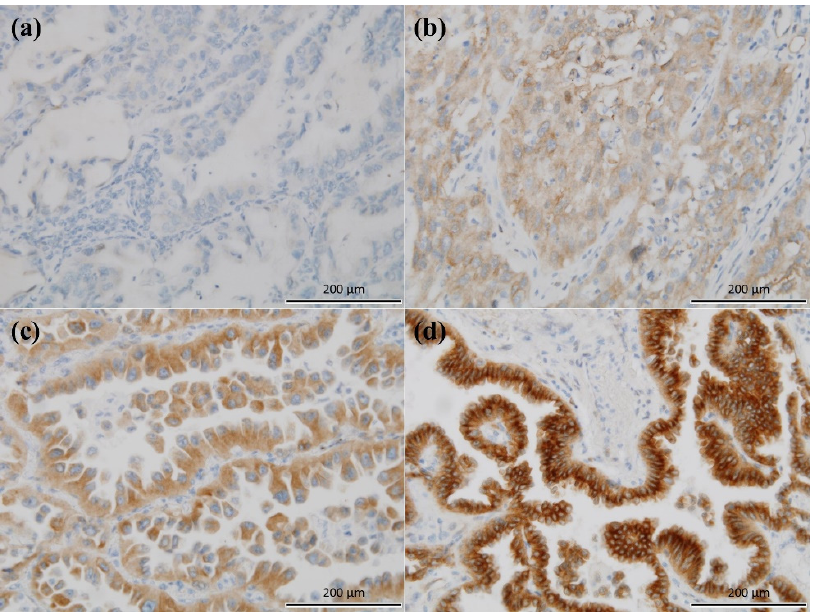
Figure 1. Microtubule-associated tumor suppressor 1 (MTUS1) immunostaining in lung adenocar- cinoma (×200). ( a ) Negative, ( b ) weak, ( c ) moderate, and ( d )